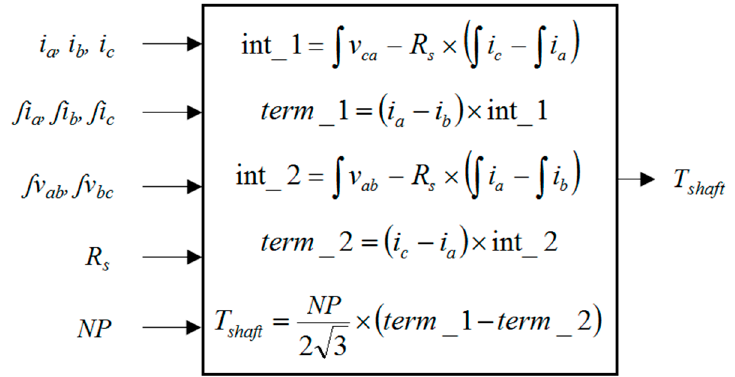
Figure 8. Air-Gap Torque (AGT) method procedure.